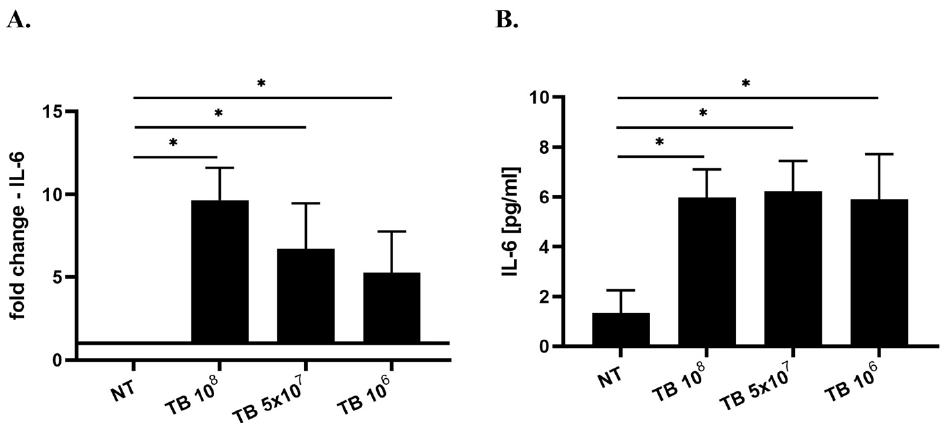
Figure 5. Effect of TB on the gene expression and release of IL-6 by THP-1-derived macrophages. THP-1-derived macrophages were incubated for 4 h with different concentrations of TB and the effect on the gene expression and protein release of IL-6 was assessed by Real Time PCR ( A ) and ELISA ( B ), respectively. Data are expressed as mean ± SD (N = 4). For statistical analysis, repeated measures ANOVA with Bonferroni post hoc test was applied. * p < 0.05 vs. NT.